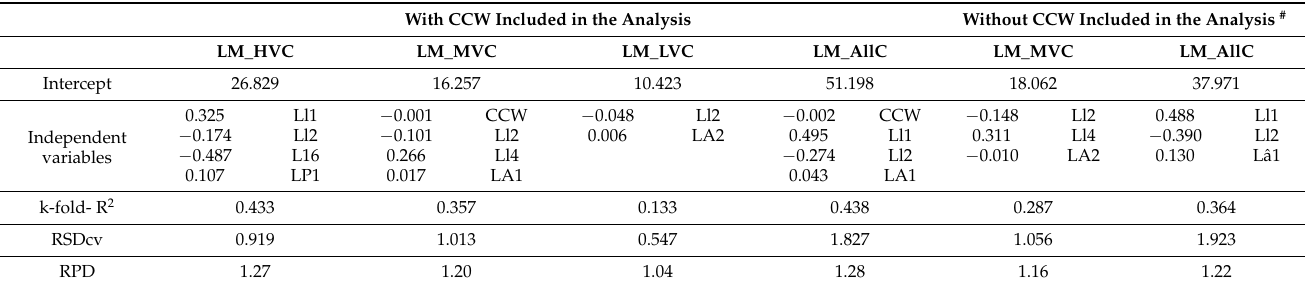
Table 6. Equations and corresponding coefficient of determination k-fold (k-fold- R 2 ), residual standard deviation of the cross-validation (RSDcv) and ratio of prediction to deviation (RPD) for the prediction of lean meat percentage with and without cold carcass weight (CCW) included in the analysis ( n =